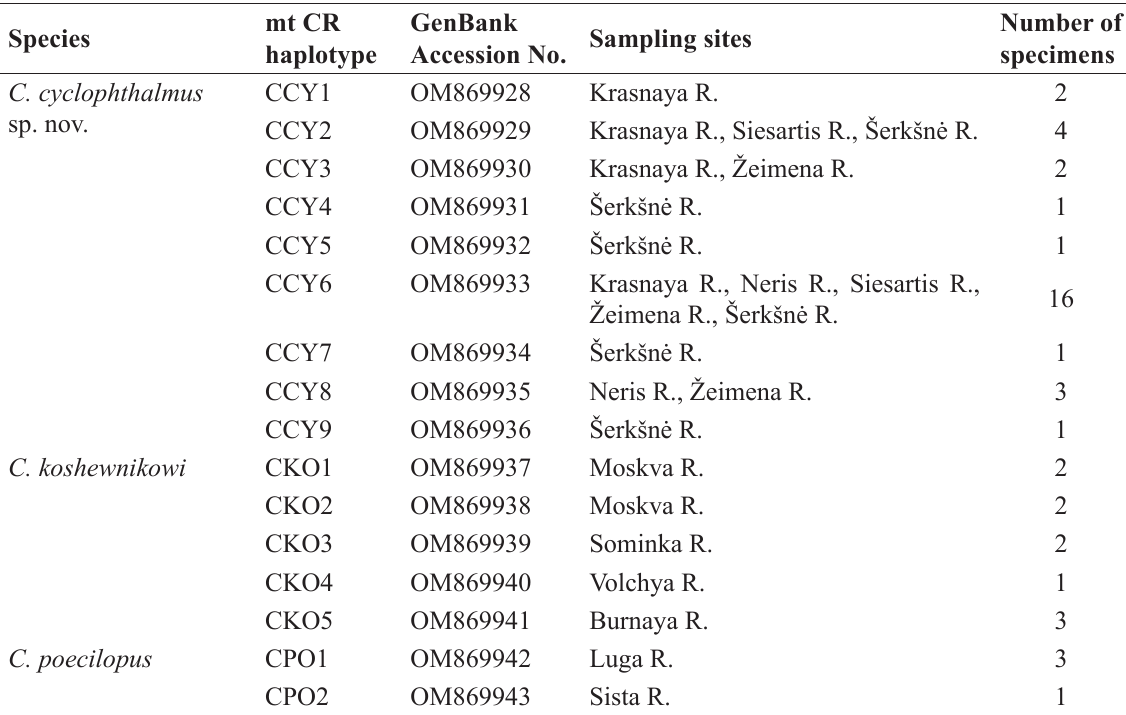
Table 4. The geographic distribution of detected mt CR haplotypes of Cottus cyclophthalmus sp. nov., C. koshewnikowi Gratzianov, 1907, and C. poecilopus Heckel, 1837.